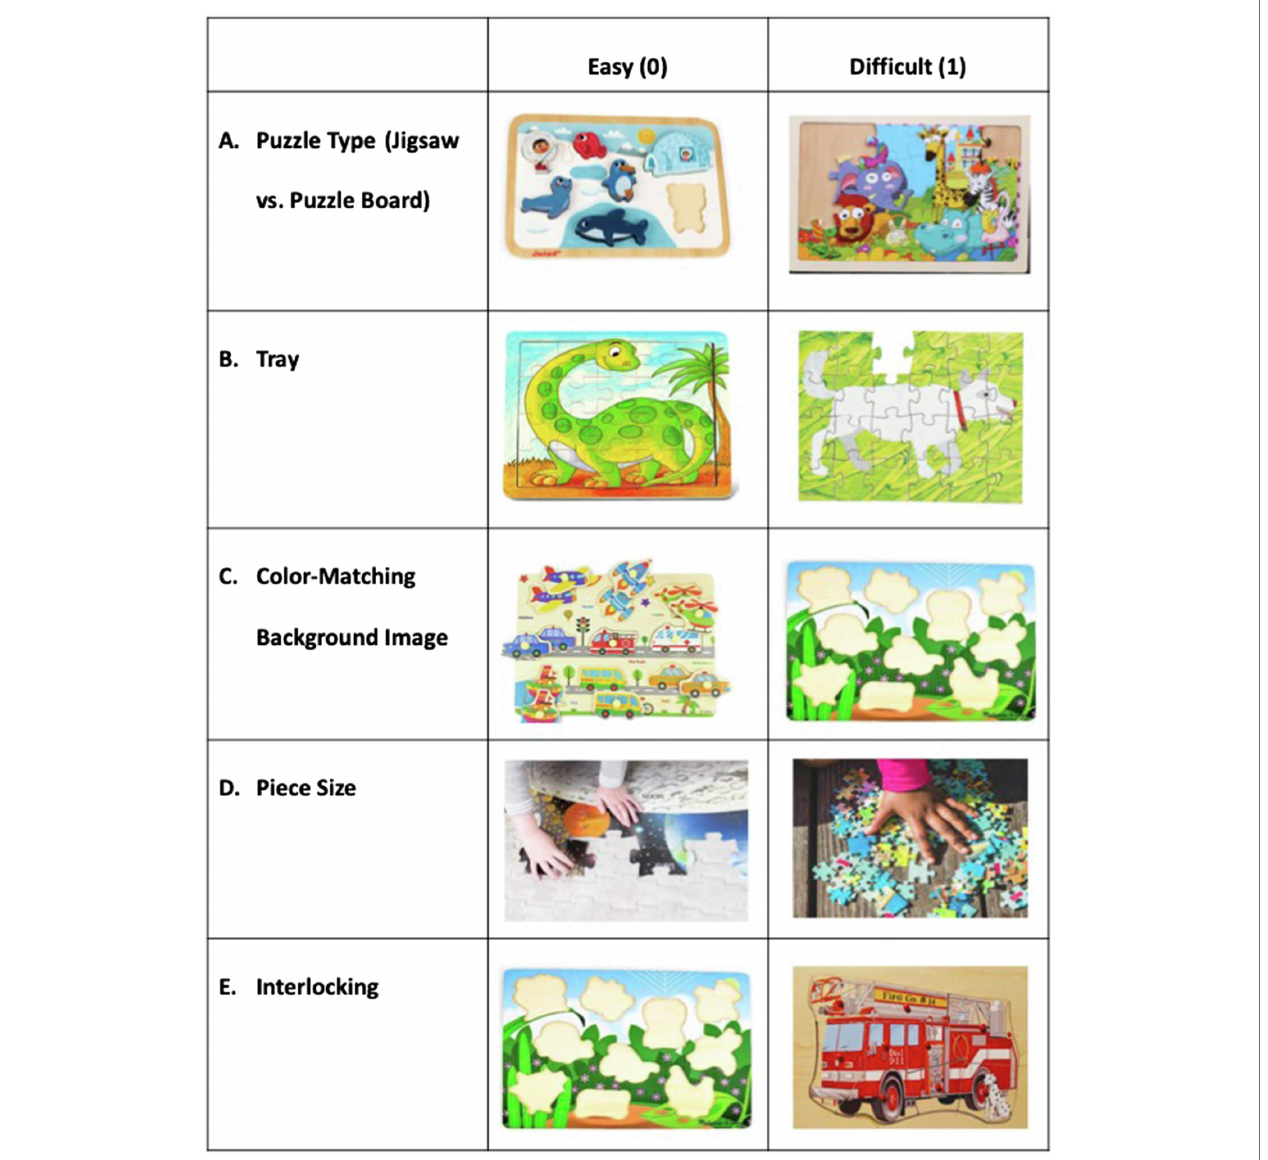
FIGURE 2 | Puzzle dimensions that were coded for difficulty. (A) Puzzle type, (B) Tray, (C) Color-matching background image, (D) Piece size, (E)